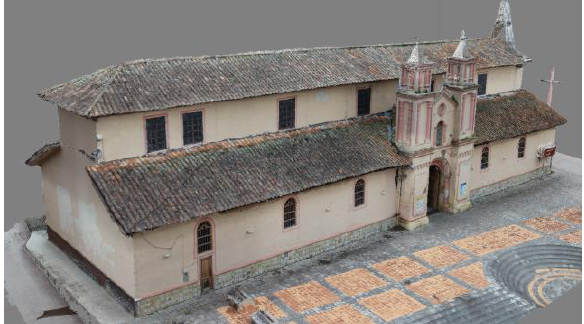
Figure 10 . Nabón’s church textured 3D